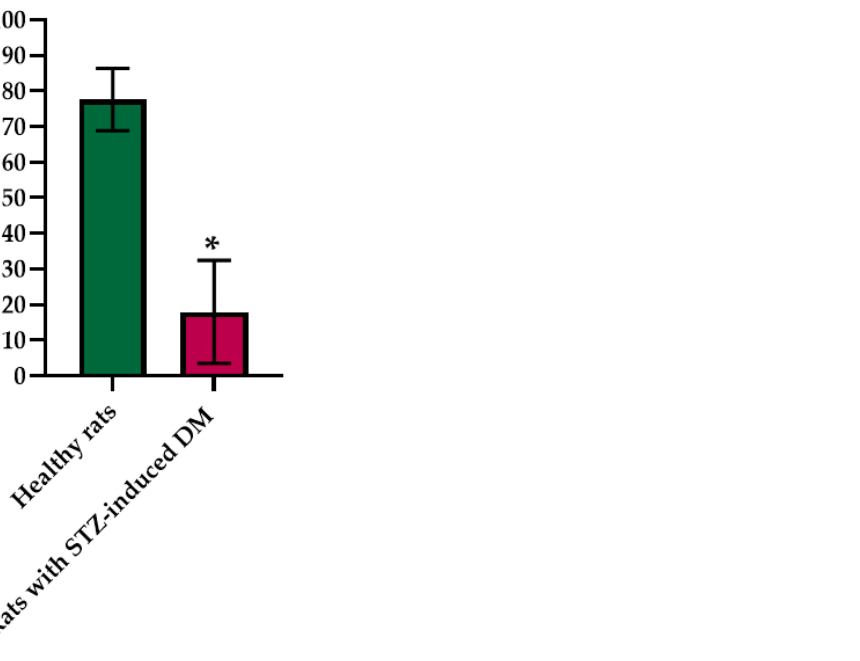
Figure 3. Analysis of the percentage of beta cells in the pancreas islets of healthy rats and of rats with STZ-induced DM. *— p = 0.00000.